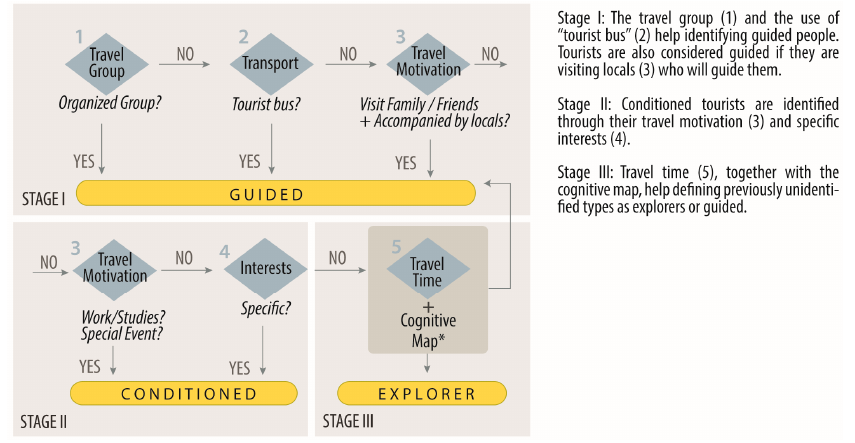
Figure 7. Decision diagram for determining the type of a tourist, according to the five main factors impacting the travel